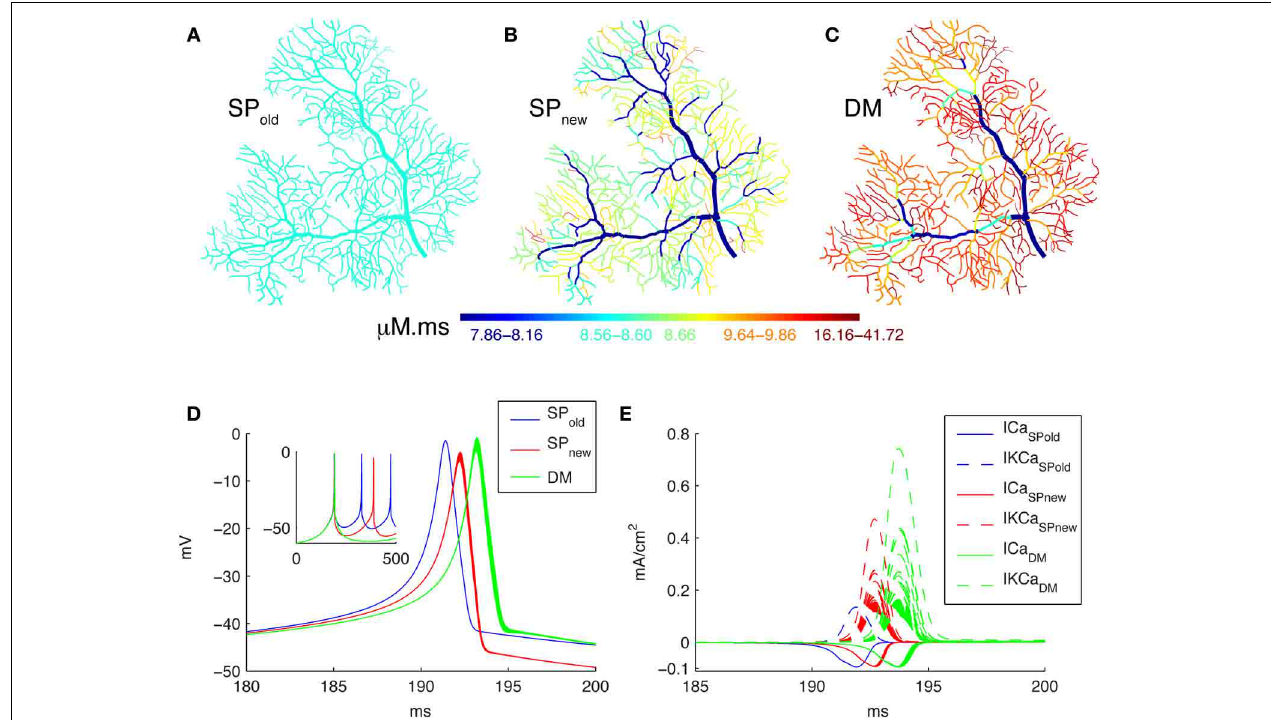
Ca 2 + pool model using SP new mechanism results in variable Ca 2 + levels. (C) Detailed Ca 2 + dynamics model with buffering and 1D diffusion results in variable Ca 2 + levels with larger Ca 2 + gradients. (D) Voltage traces show the first spike of the Ca 2 + burst for each model in all dendritic compartments for the 3 different models (see color code in Figure). The inset shows